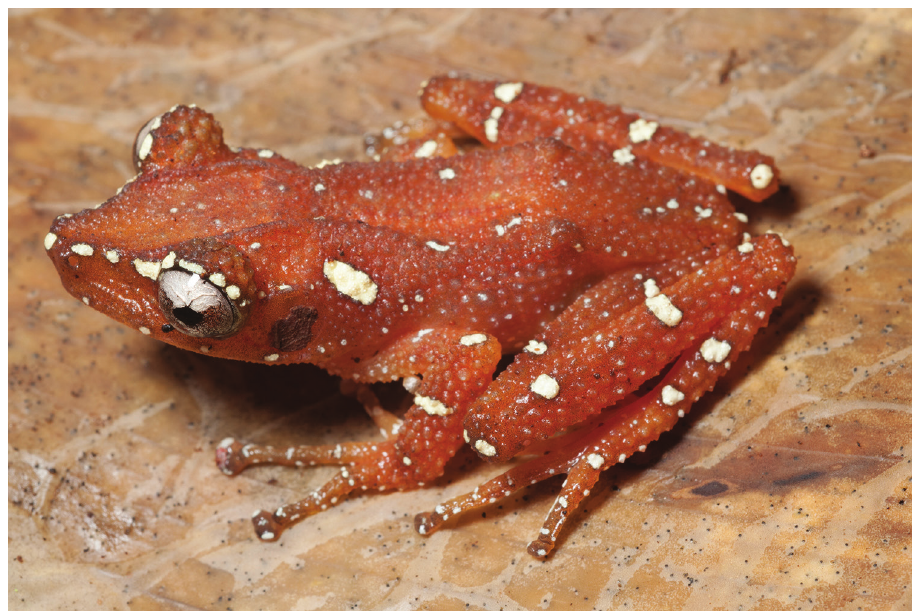
Figure 28. Theloderma spinosum female (KU 333805) from May-Impit, Mt. Hilong-hilong, Municipality of Remedios T. Romualdez, Agusan del Norte Province. Photo: